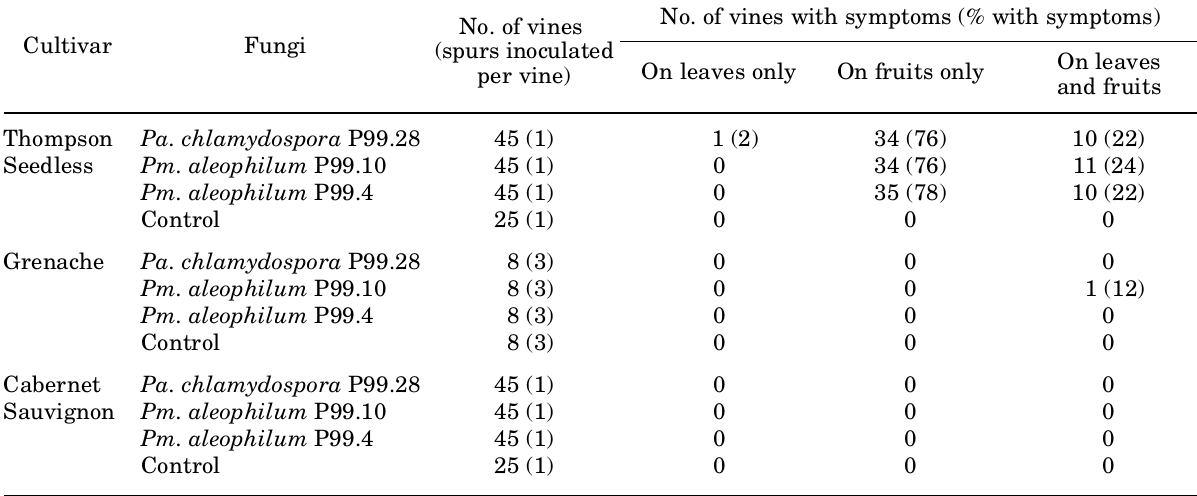
Table 1. Incidence of esca on three grape cultivars three years after inoculation of pruning wounds with spore suspension (approximately 1 (cid:1) 10 6 spores ml -1 water) of an isolate of Phaeomoniella chlamydospora and two isolates of Phaeoacremonium aleophilum